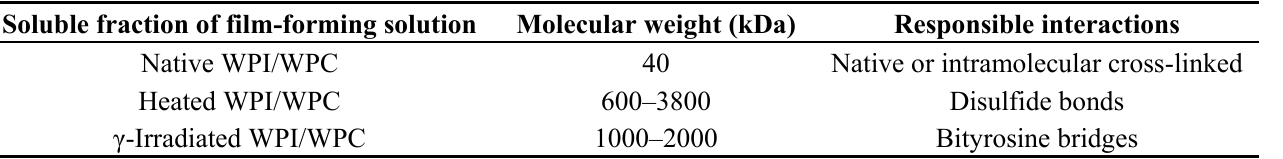
Table 2. Molecular weight fractions of native, heated and γ-irradiated whey protein isolate (WPI) and WPC (whey protein concentrate) solutions